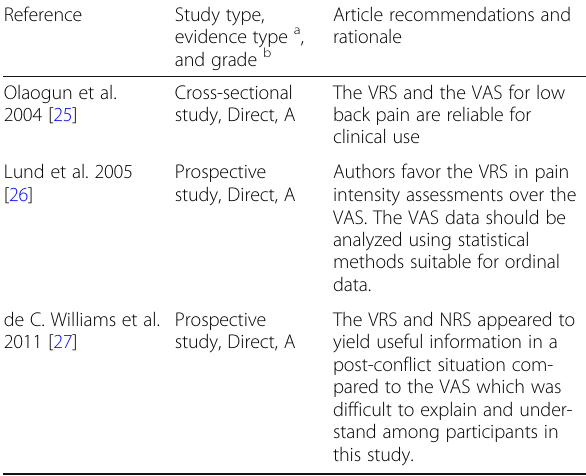
Table 4 Summary of key evidence to support the verbal